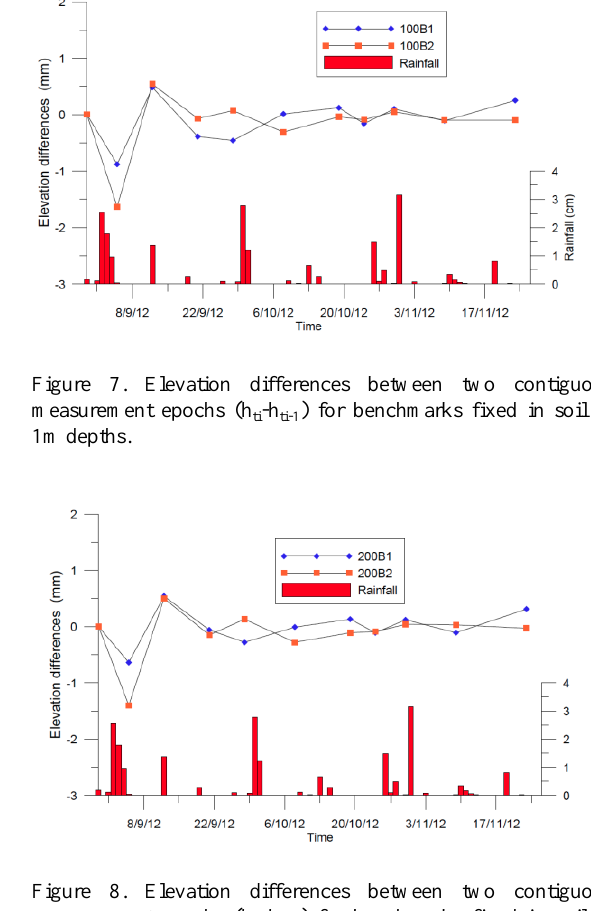
Figure 8. Elevation differences between two contiguous measurement epochs (h ti -h ti-1 ) for benchmarks fixed in soil at 2m depths. If we consider instead of single rainfall events, the cumulate rainfall we can quantify the overall changes in elevation observed in the period of few months (August-November).